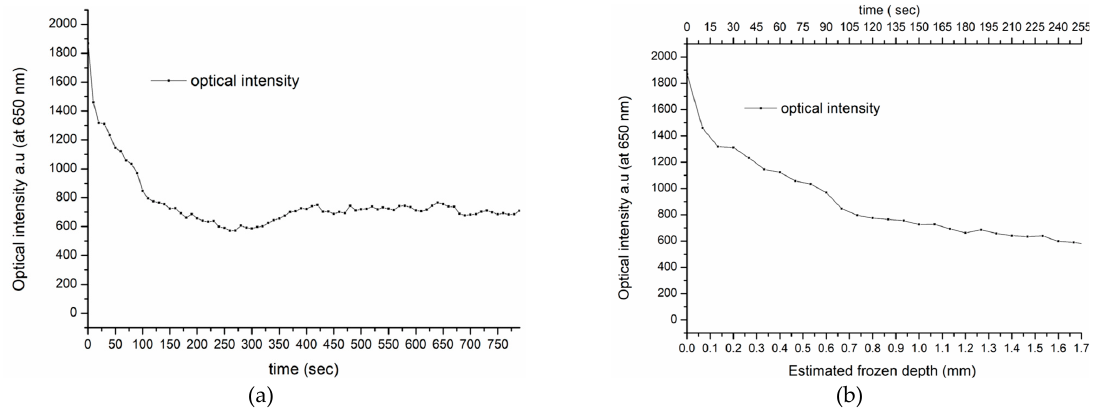
Figure 8. Thawing timeline of human tissues at 650 nm. ( a ) Total thawing timeline of human tissues. ( b ) Thawing timeline of initial 250 s of human tissue’s estimated frozen depth (mm).